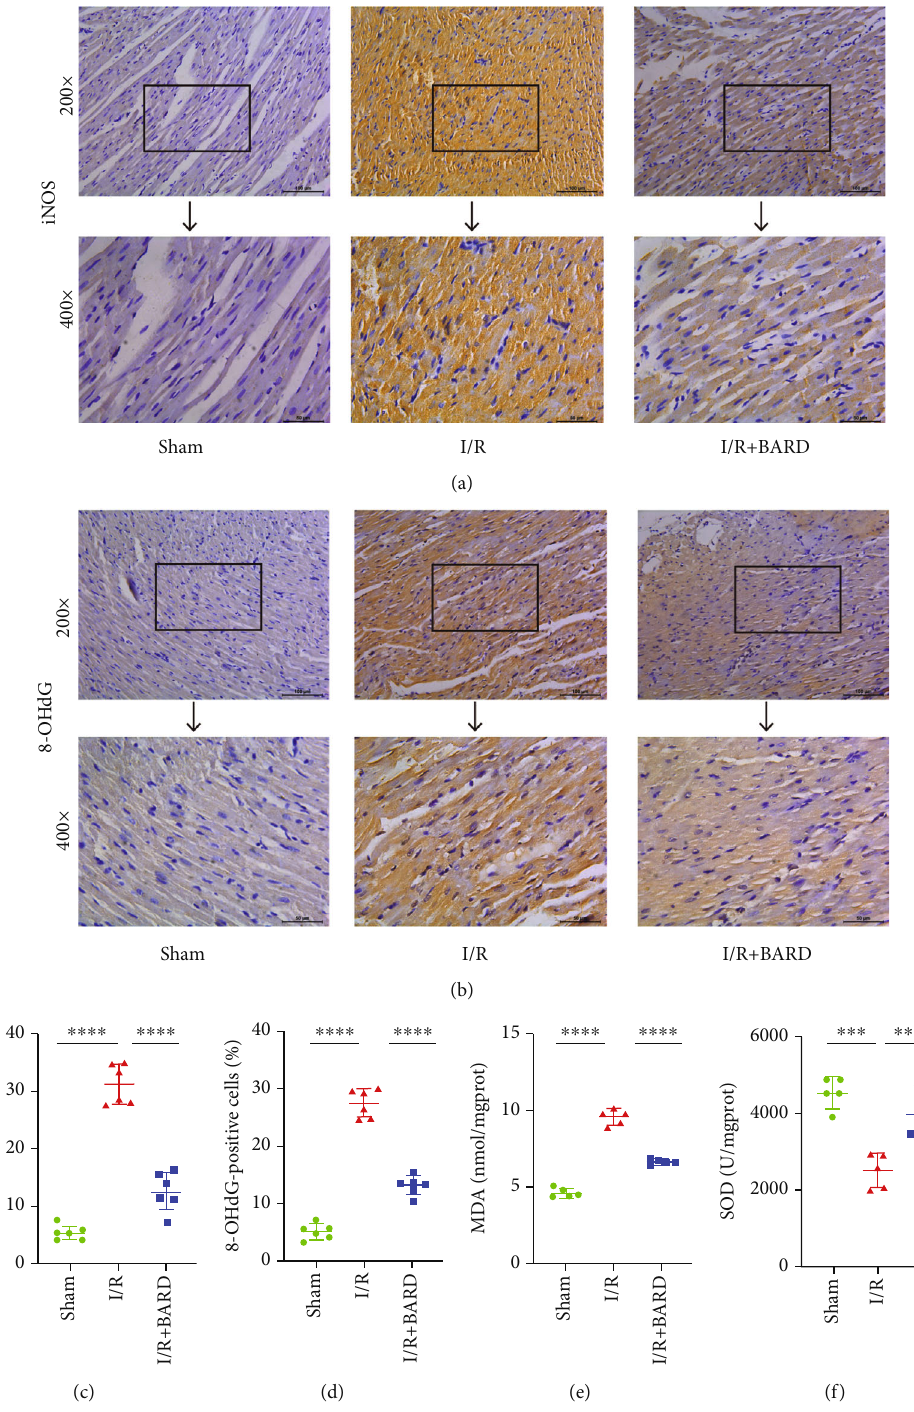
Figure 4: BARD alleviates oxidative stress-induced myocardial I/R. (a) iNOS immunohistochemistry staining. (b) 8-OHdG immunohistochemistry staining. (c) The amounts of iNOS-positive cells ( n = 6 ). (d) The amounts of 8-OHdG-positive cells ( n = 6 ). (e) MDA level ( n = 5 ). (f) SOD content ( n = 5 ). Magni fi cation of microscope: × 200 and × 400. Scale bar: 50 μ m and 100 μ m. ∗∗ P < 0 : 01 , ∗∗∗ P < 0 : 001 , and ∗∗∗∗ P < 0 : 0001